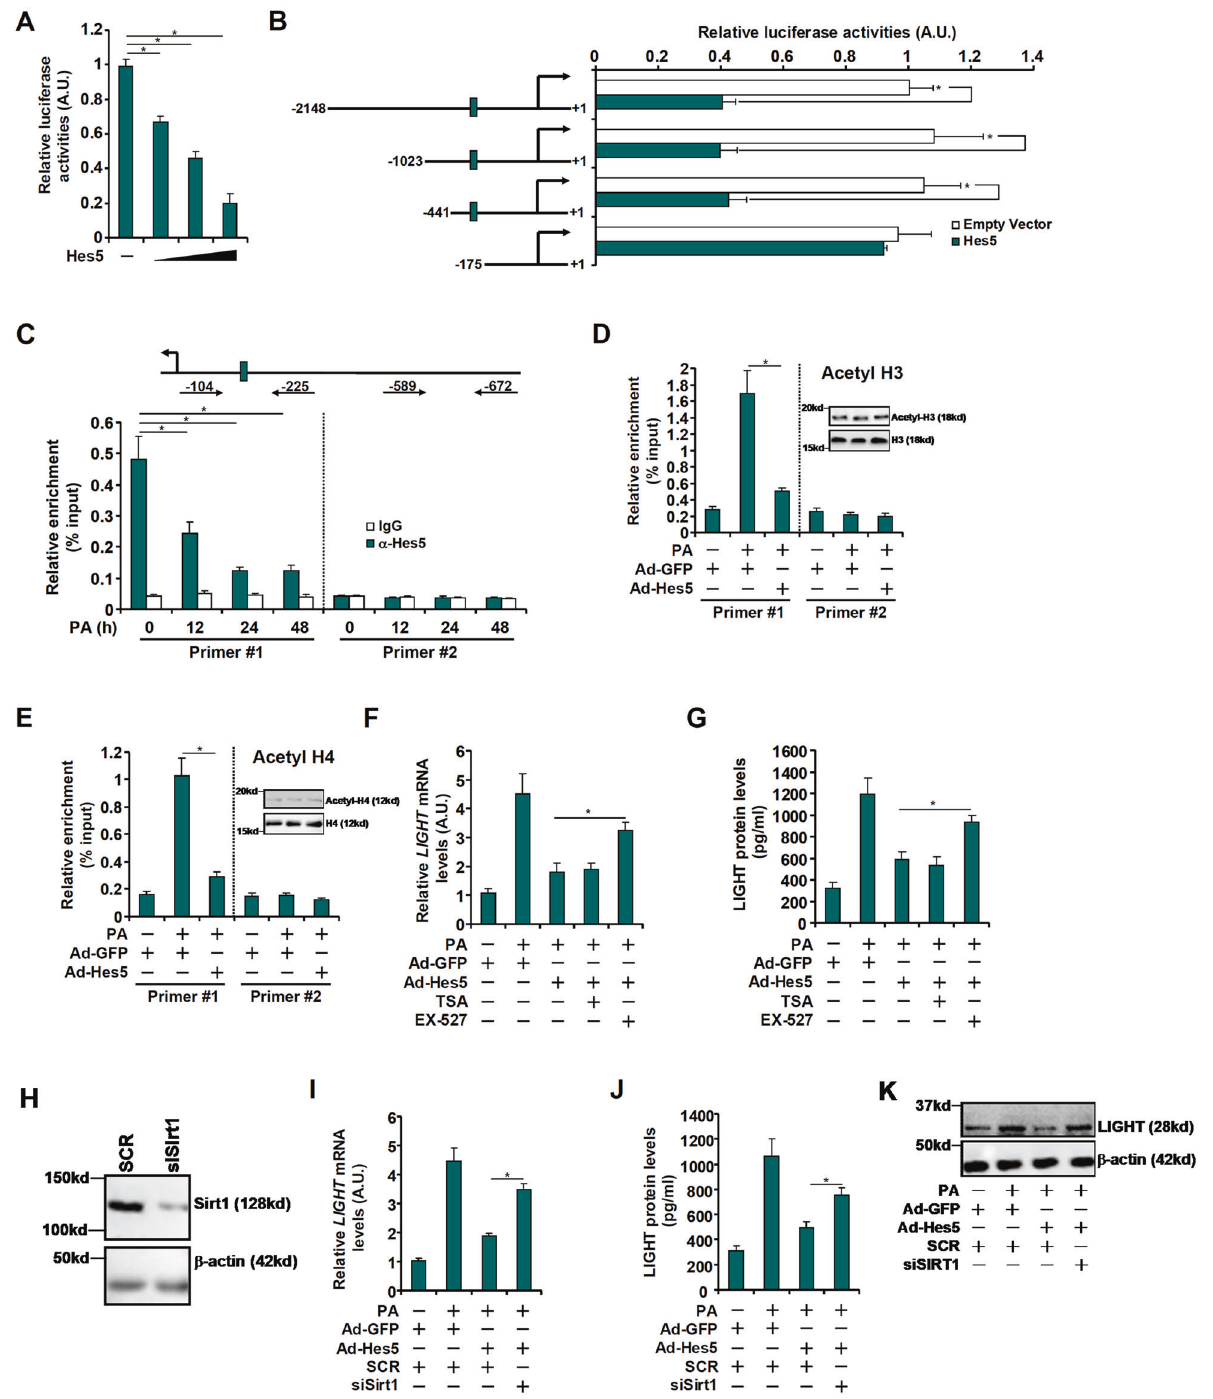
Fig. 4 HES5 directly binds to the LIGHT promoter and represses LIGHT transcription. A A LIGHT promoter-luciferase construct ( − 2186/ + 1) were transfected into HepG2 cells with or without HEY5. Luciferase activities were normalized by protein concentration and GFP fl uorescence. B Different LIGHT promoter-luciferase constructs were transfected into HepG2 cells with or without HES5. Luciferase activities were normalized by protein concentration and GFP fl uorescence. C Primary murine hepatocytes were treated with palmitate (0.3 mM) and harvested at indicated time points. ChIP assay was performed with anti-HES5 or IgG. D , E Primary murine hepatocytes were transduced with Ad-HES5 or Ad-GFP followed by treatment with PA (0.3 mM). ChIP assay was performed with anti-acetyl H3 and anti-acetyl H4. Inset, global histone H3/H4 and acetyl H3/H4 levels were examined by western blotting. F , G Primary murine hepatocytes were transduced with Ad-HES5 or Ad-GFP followed by treatment with PA (0.3 mM) in the presence of absence of TSA (100 nM) or EX-527 (1 μ M). LIGHT expression was examined by qPCR and ELISA. H – K Primary murine hepatocytes were transduced with Ad-HES5 or Ad-GFP, transfected with siRNA-targeting SIRT1 or scrambled siRNA (SCR) and treated with PA (0.3 mM). SIRT1 knockdown ef fi ciency was examined by western. LIGHT expression was examined by qPCR, ELISA, and western